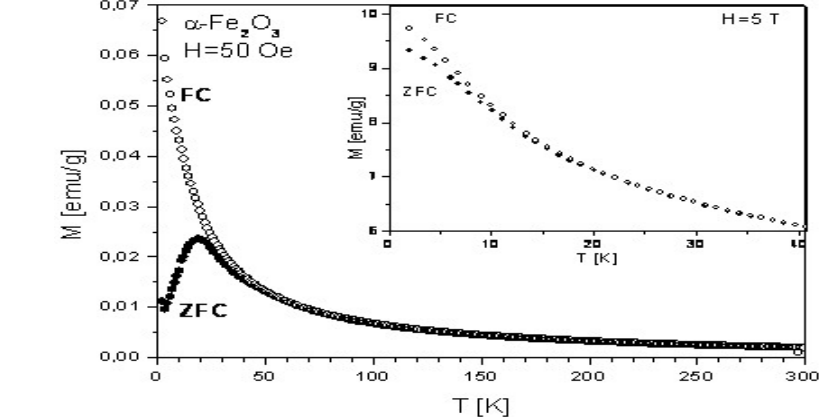
(ZFC i FC merenja) u magnetnim poljima ja č ine 50 Oe i 5 T Figure 4 – Temperature dependence of the zero-field-cooled (ZFC, solid symbols) and field-cooled (FC, open symbols) magnetization measured in a field of 50 Oe and 5 T